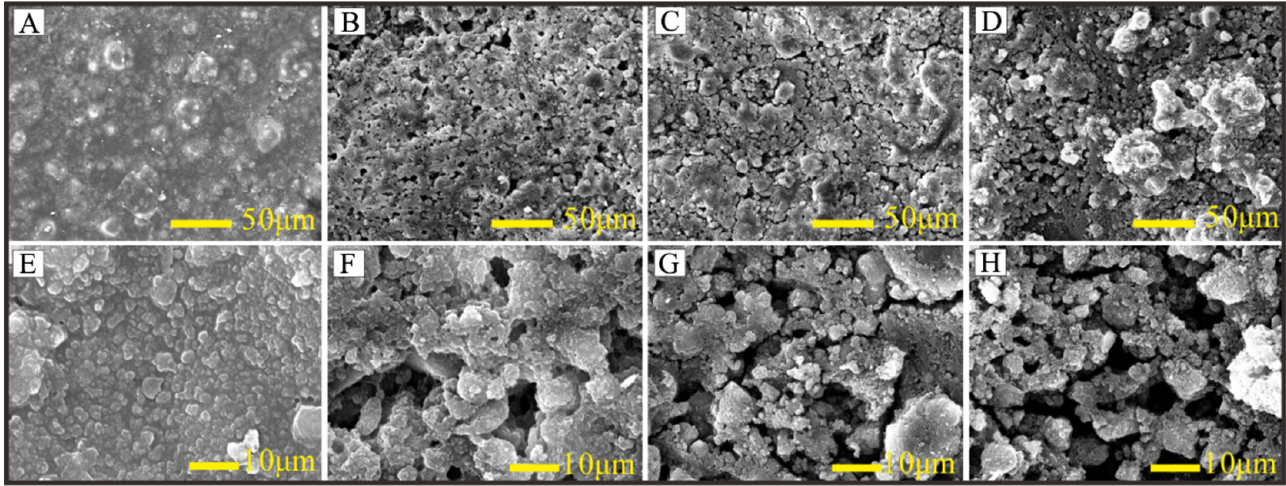
Figure 2. Surface topography of polished planes sprayed with different concentrations of hydro- phobic nano-SiO 2 coatings. ( A , E ) 0.025 g/mL; ( B , F ) 0.05 g/mL; ( C , G ) 0.075 g/mL; ( D , H ) 0.1 g/mL.